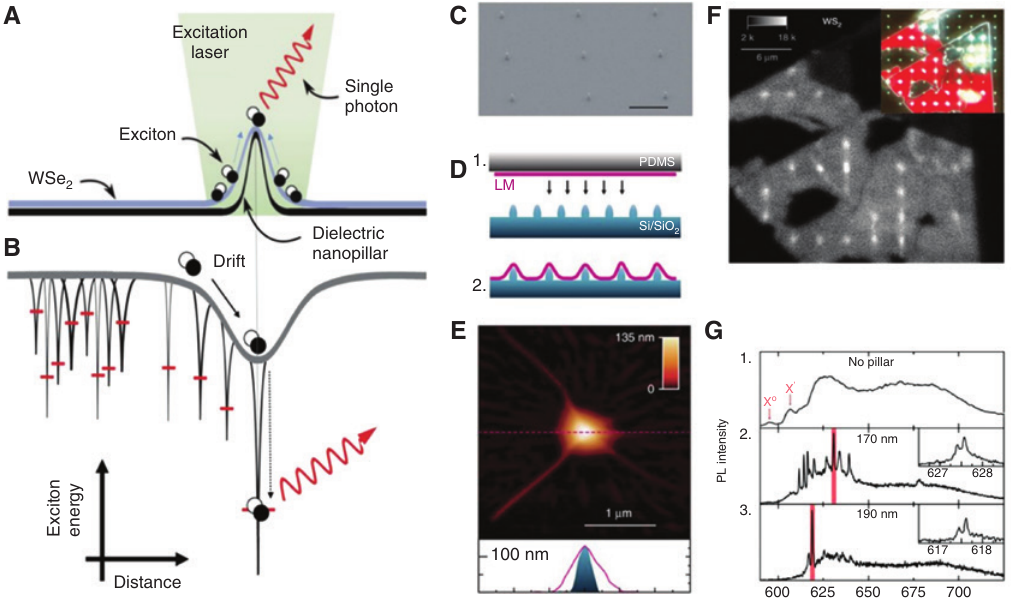
Figure 4: Deterministic generation of strain defined quantum emitters in 2D semiconductors. (A and B) Schematic and band energy diagram of exciton funneling at a nanopillar. (C) SEM micrograph of the nanopillars. (D) Dry transfer technique of the TMDC on nanopillar. (E) AFM image of the TMDC over a nanopillar. (F) Integrated PL intensity raster scan of a 1L-WS deposited on top of a 3 μ m spaced, 170-nm-high nanopillar array, taken at 300 nW μ m −2 , 532 nm laser excitation at 10 K. The color-scale bar maximum is 18 kcounts s −1 . Inset, true-color dark-field micrograph of the same area. The red region corresponds to the WS spectra of 1L-WS at 10 K. Panel 1 shows a spectrum taken from a flat region away from nanopillars. Red arrows indicate unbound monolayer 2 neutral (X 0 ) and charged (X − ) excitons. Panels 2 and 3 show the representative spectra of WS Insets, high-resolution PL spectra of the red highlighted spectral regions, showing the FSS of the peaks. Reproduced with permission from Refs. [53, 54], Nature Publishing